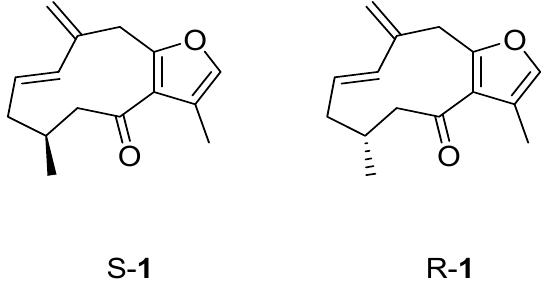
Figure 3. Structures of the two diasteroisomers of compound 1 .